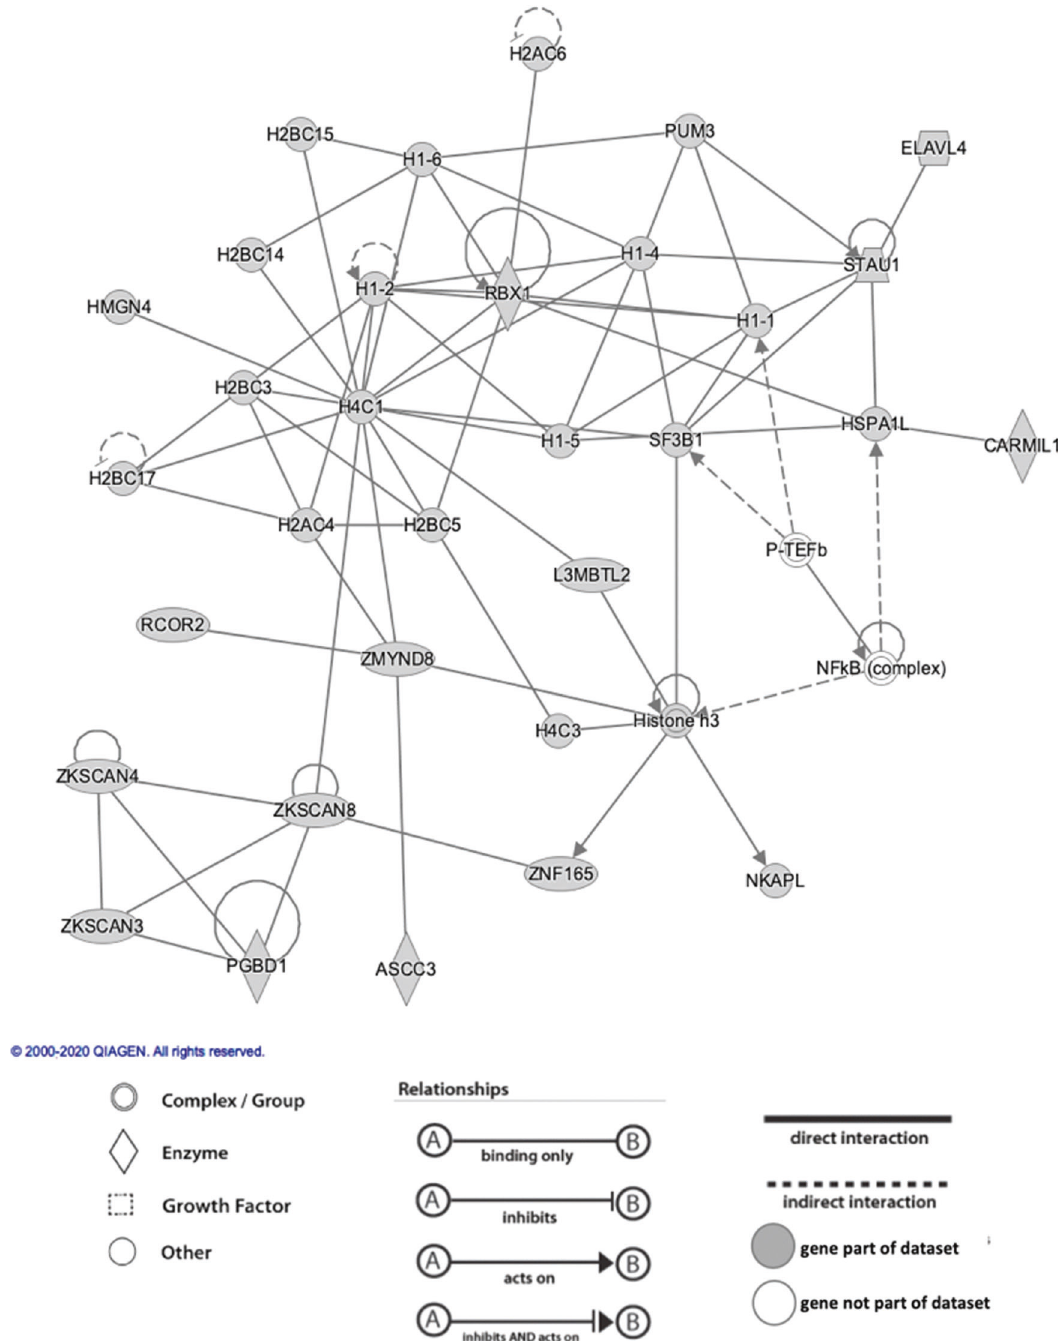
Fig. 3 IPA ® top network of MET2 genes associated with SCZ and MDD at p < 5 × 10 − 8 . Annotated network functions include endocrine system disorders, gastrointestinal disease, immunological disease. H4 clustered histone 1 (H4C1), histone H3, and E3 ubiquitin-protein ligase (RBX1) are identi fi ed as nodes with most network cycle, cellular assembly and organization, and DNA replication, recombination, and repair . Adenosine triphosphate (ATP), estrogen receptor, and EP300 (encoding p300, a histone acetyltransferase) were identi fi ed as nodes with most network interactions (Supplementary Fig. 1). Networks 3, 4, and 5 (each with IPA ® score 32), respectively, identi fi ed tumor necrosis factor (TNF), extracellular-signal-regulated kinases (ERK1/2), and heat shock protein family D member 1 (HSPD1) as most highly connected nodes (Supplementary Figs. 2 – 4).